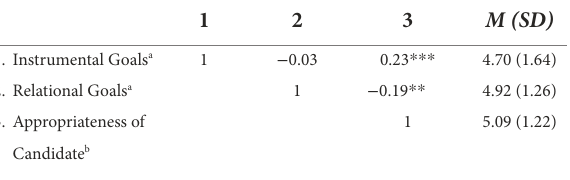
TABLE 1 Pearson correlations coefficients between study variables, means, and standard deviations (Study